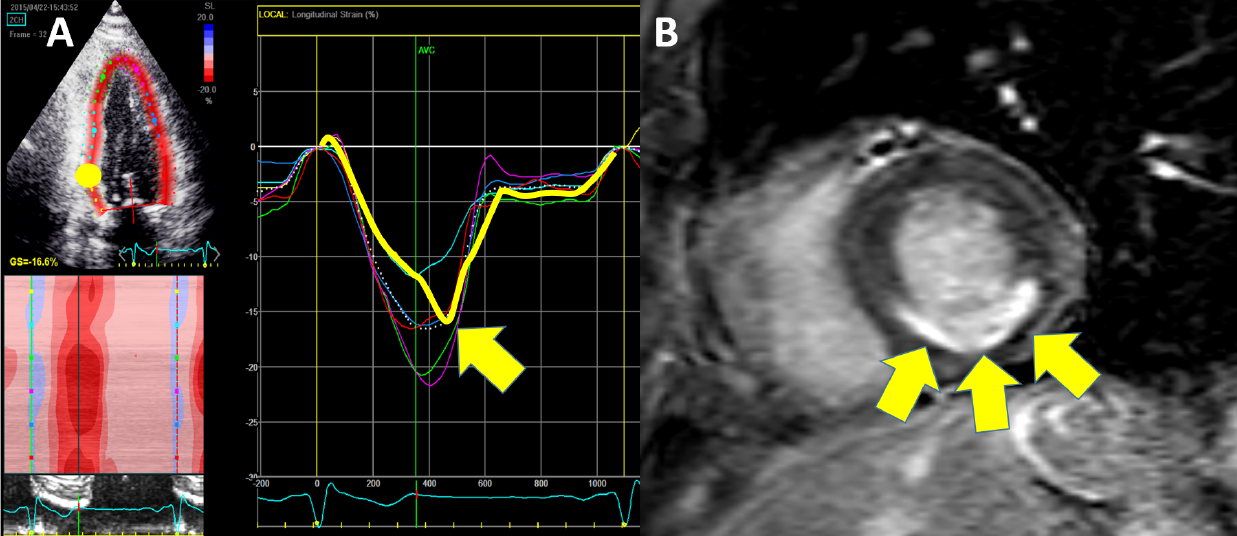
Figure 3. Abnormal deformation in myocardial infarction. ( A ) Segmental longitudinal strain curves in an apical two-chamber view of a patient with inferior infarction. The bold yellow curve is derived from the infarcted inferobasal segment. Note the pronounced post-systolic shortening (arrow). ( B ) Cardiac magnetic resonance imaging with delayed enhancement of the same patient. A scar is present in the basal inferior region (arrows). Abbreviations: AVC, aortic valve closure; GS, global strain.